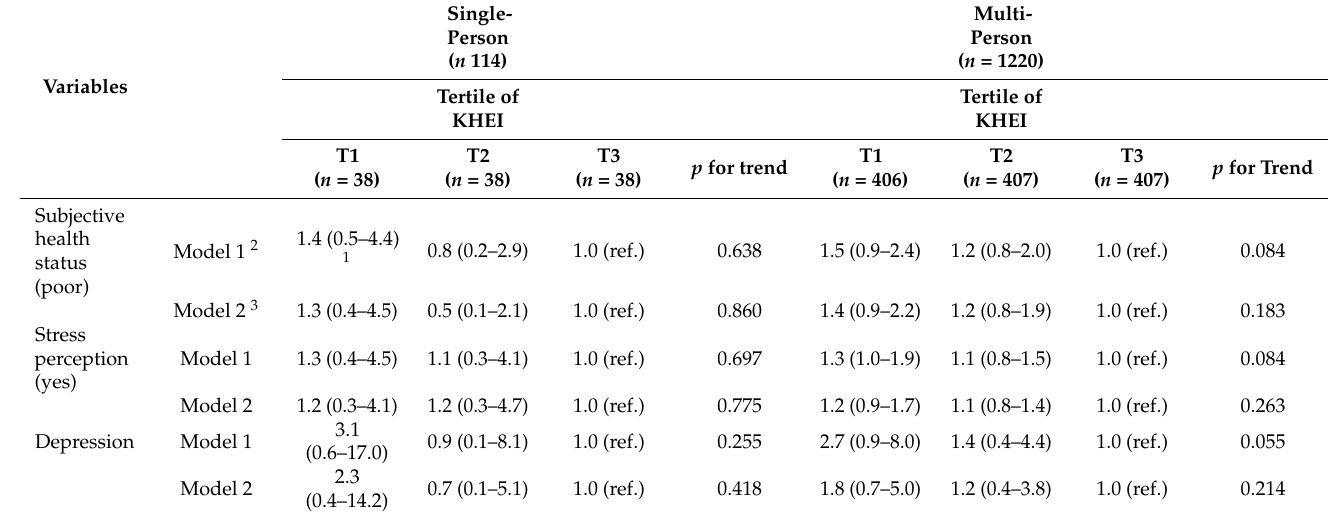
Table 6. ORs for mental health-related outcomes according to KHEI score by household size in